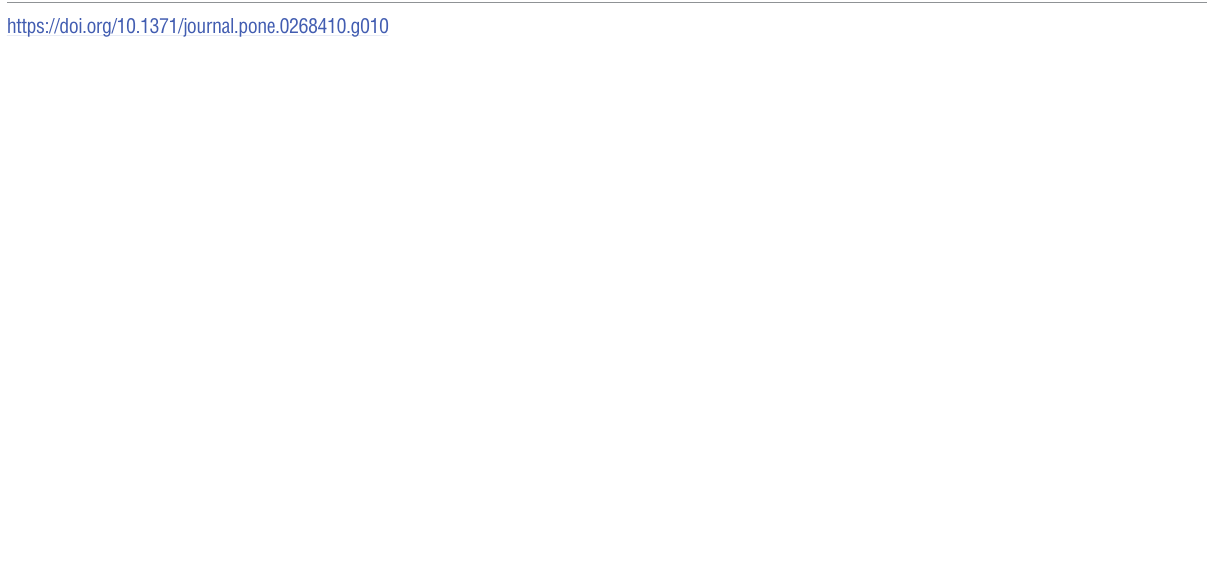
PLOS ONE | https://doi.org/10.1371/journal.pone.0268410 June 28, 2022 21 /